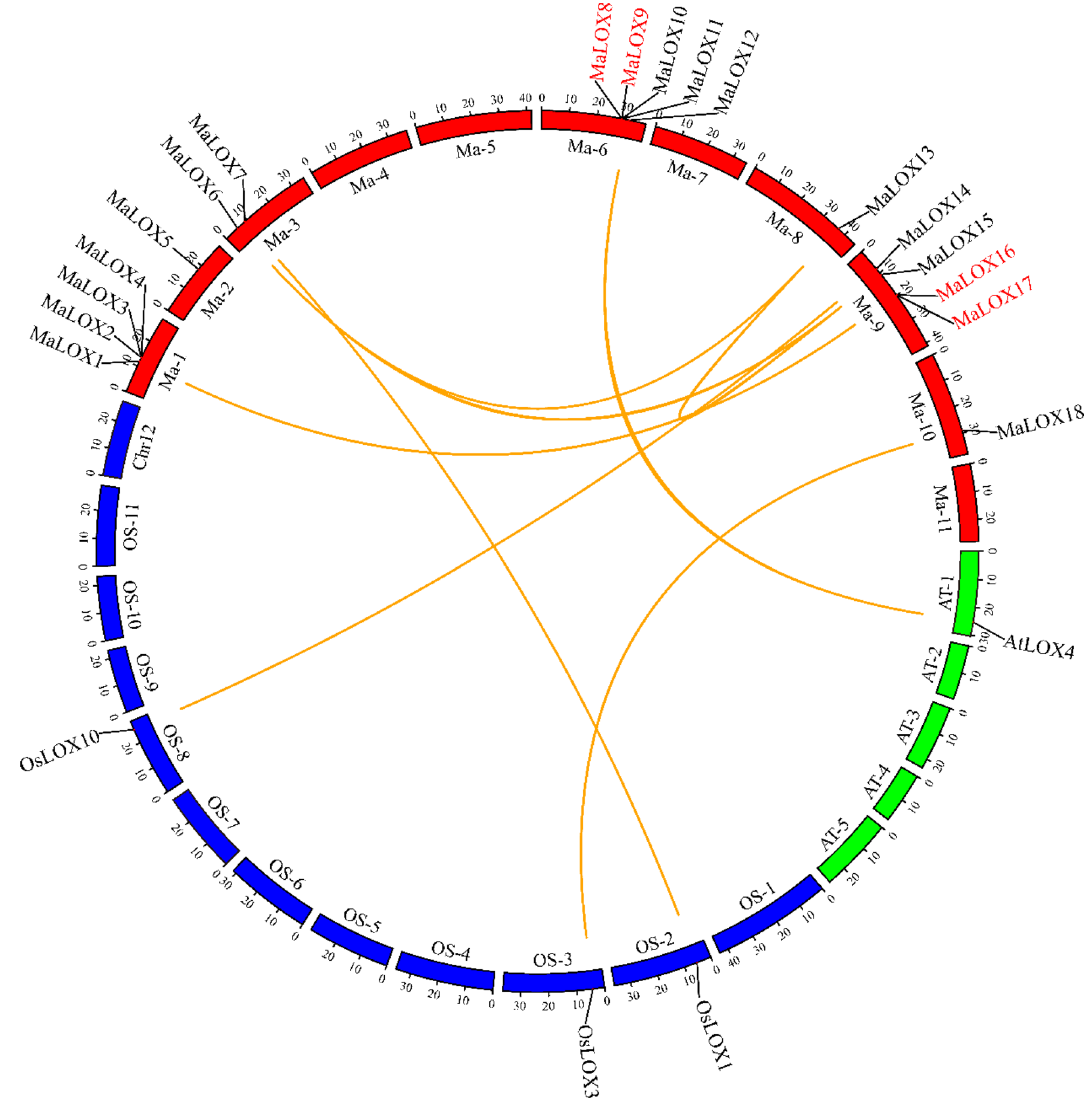
Figure 5. Collinear distribution of MaLOX genes. The orange line indicates the collinearity between the MaLOXs , and the gene names in red are tandem replication genes.